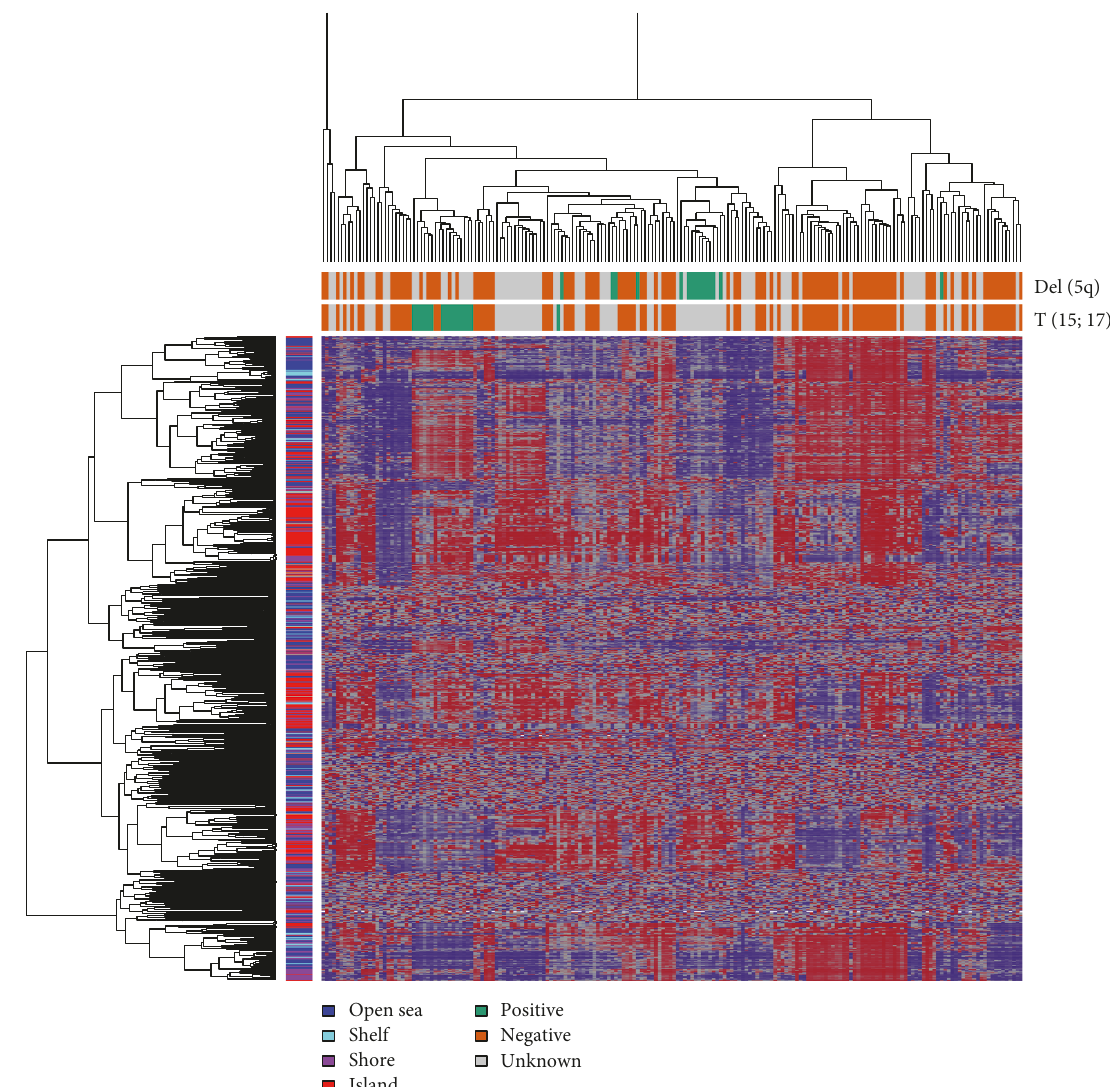
Figure 4: Hierarchical clustering of AML samples. Heatmap displayed only sites with the highest variance across all samples and complete linkage strategy. x -axis represents the number of patients, and y -axis represents di ff erent CpG regions. Gray color in across x -axis side bar represents unknown for particular trait. Color key represents beta value (red means hypomethylated and blue means hypermethylated). Del (5q)-positive patients show mostly hypermethylation across the genomic regions. T (15; 17)-positive patients show hypomethylation across the genomic